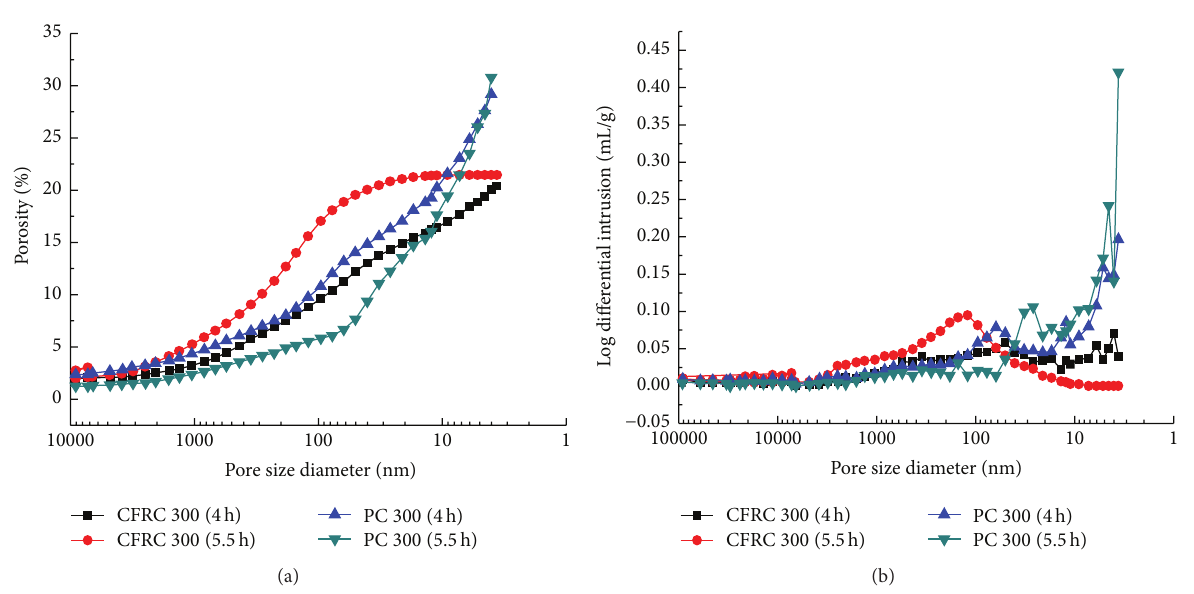
porosity is 5% at 20 ∘ C, 20% at 300 ∘ C, 25% at 600 ∘ C, and 30% at 800 ∘ C. Similarly, the porosities of heated PCs are always 10 to 15% greater than those of CFRCs at the same